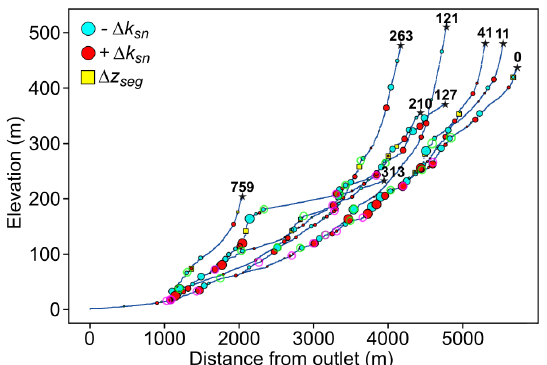
Figure 7. Knickpoint extraction for Santa Cruz Island, CA, USA, shown for the channel long profiles. These are the same knickpoints depicted in Fig. 6b. The stars and associated numbers correspond to the source numbers, and green and mauve circles correspond to the lips and bases of mapped knickpoints from Neely et al.